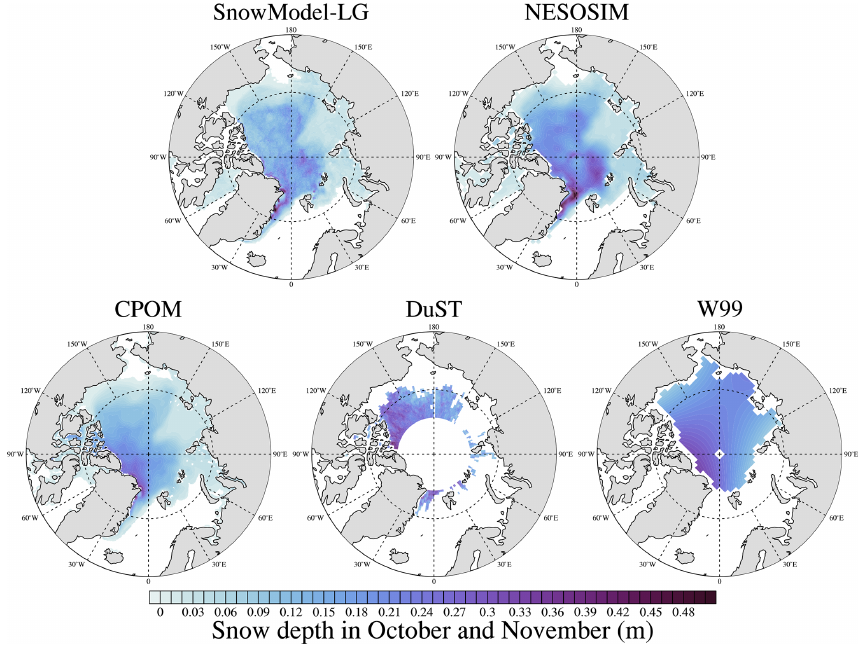
Figure 3. Mean snow depth (units: m) in autumn (October–November) 2014 for four snow products and W 99.